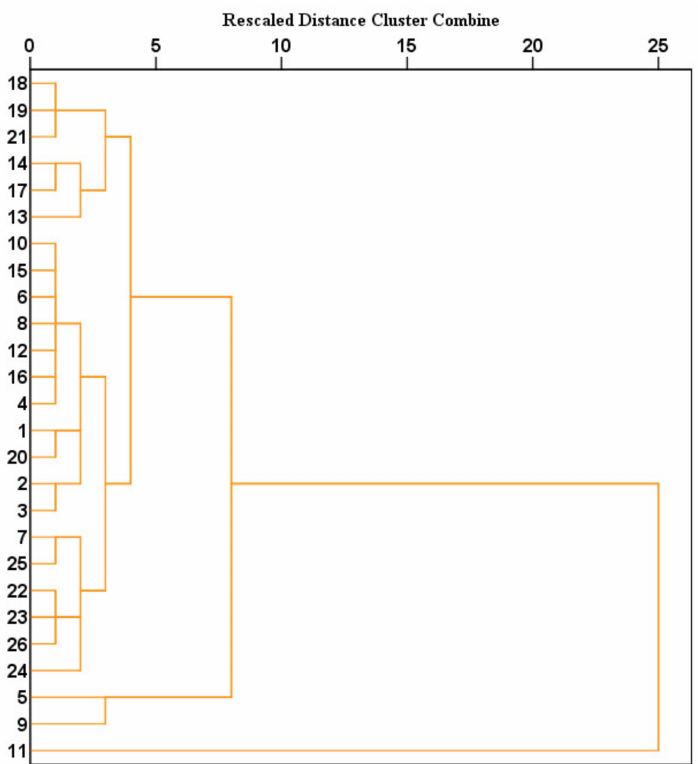
Figure 11. Cluster dendrogram from HCA for all observation